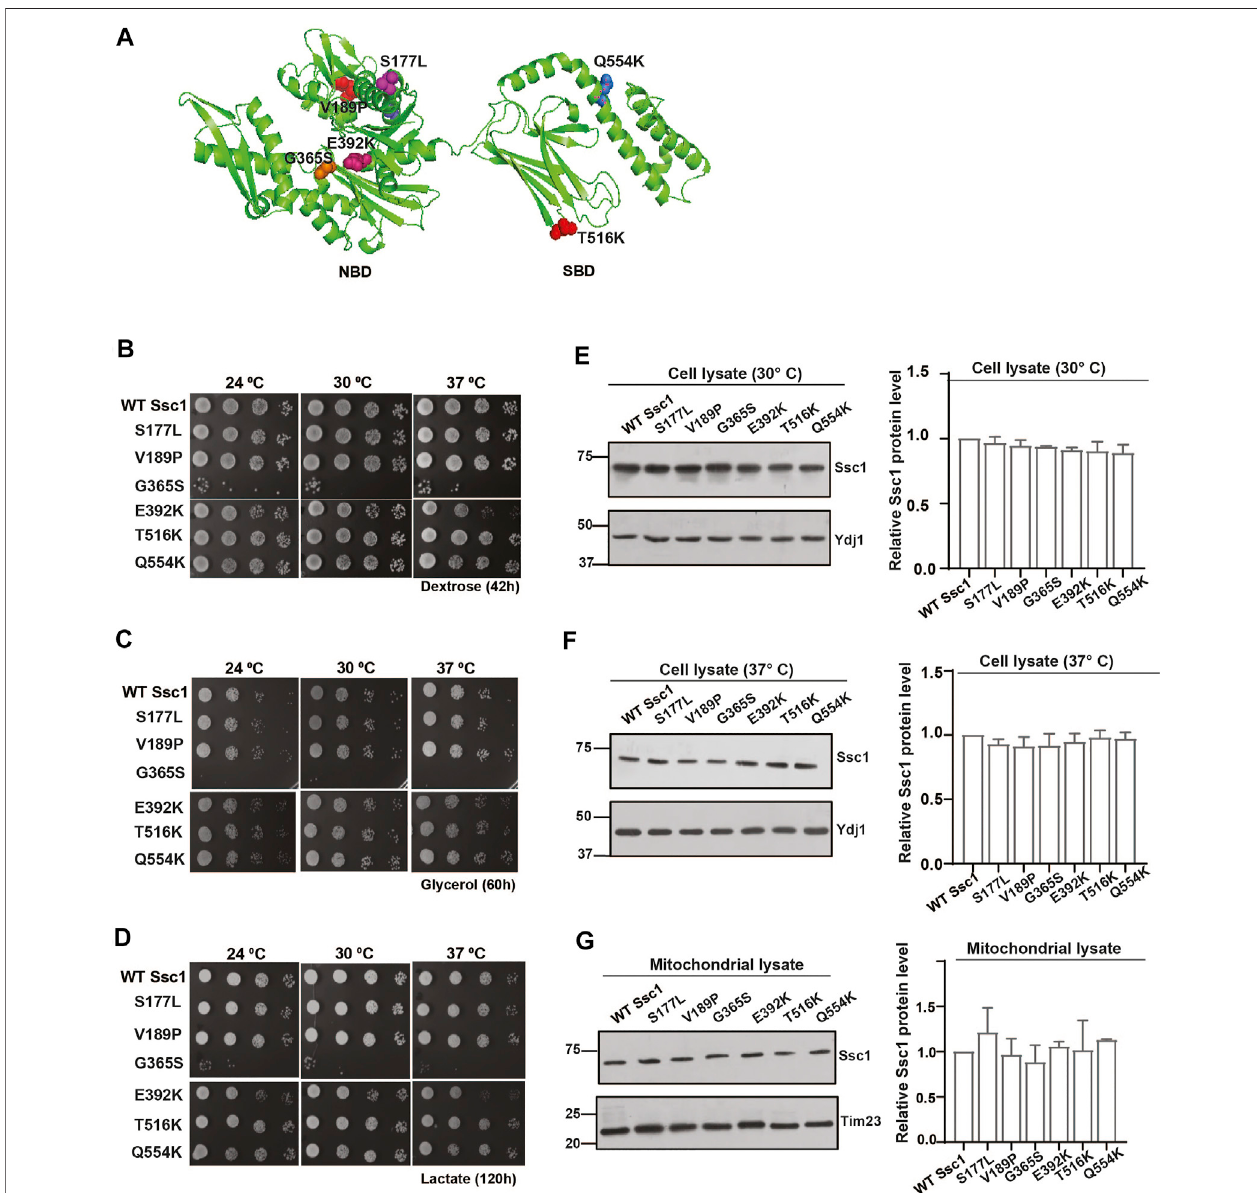
FIGURE1| GrowthphenotypeandproteinlevelsofCSAvariantsinyeast. (A) Theresiduesanalogoustothevariantsincongenitalsideroblasticanemiaarelabeled and represented as colored spheres. The modelled structure of full-length yeast Ssc1 is based on the bacterial DnaK structure (PDB ID: 2KHO). (B – D) Analysis of growth. Equivalent cells diluted ten-fold were spotted on rich media containing (B) dextrose (C) glycerol and (D) lactose and incubated at the indicated temperatures. (E – G) Steady levels ofSsc1 mutants. Celllysates ofequivalent cells grown at (E) permissivetemperature and (F) nonpermissive temperature(37 ° C)wereresolved bySDS-PAGEandtheexpressionlevelsofSsc1weredeterminedbyimmunoblottingusinganti-Ssc1antibodies.CytosolicproteinYdj1wasusedastheloadingcontrol. (G) Levels of mutants targeted to the mitochondria was measured by immunoblot analysis of 50 µg of isolated mitochondria. Tim23 was used as the mitochondrial loading control. The levels of Ssc1 were quanti fi ed using Multigauge software, normalized with respect to the wild-type and represented as Mean ± S.D of three independent